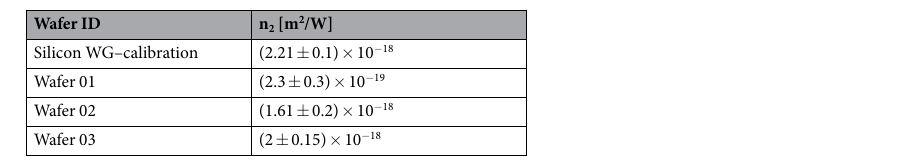
Table 2. Extracted n 2 values for 220-nm SOI, Wafer 01, Wafer 02 and Wafer 03